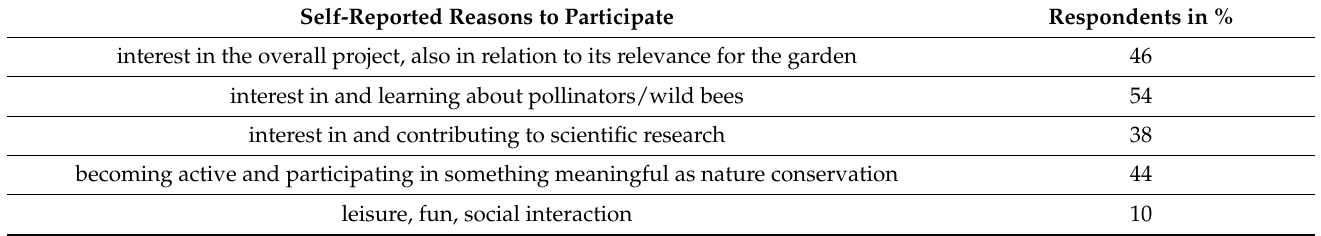
Table 4. Self-reported reasons to participate in the pollinator CS project, multiple answers possible, N = 39. Self-Reported Reasons to Participate Respondents in %